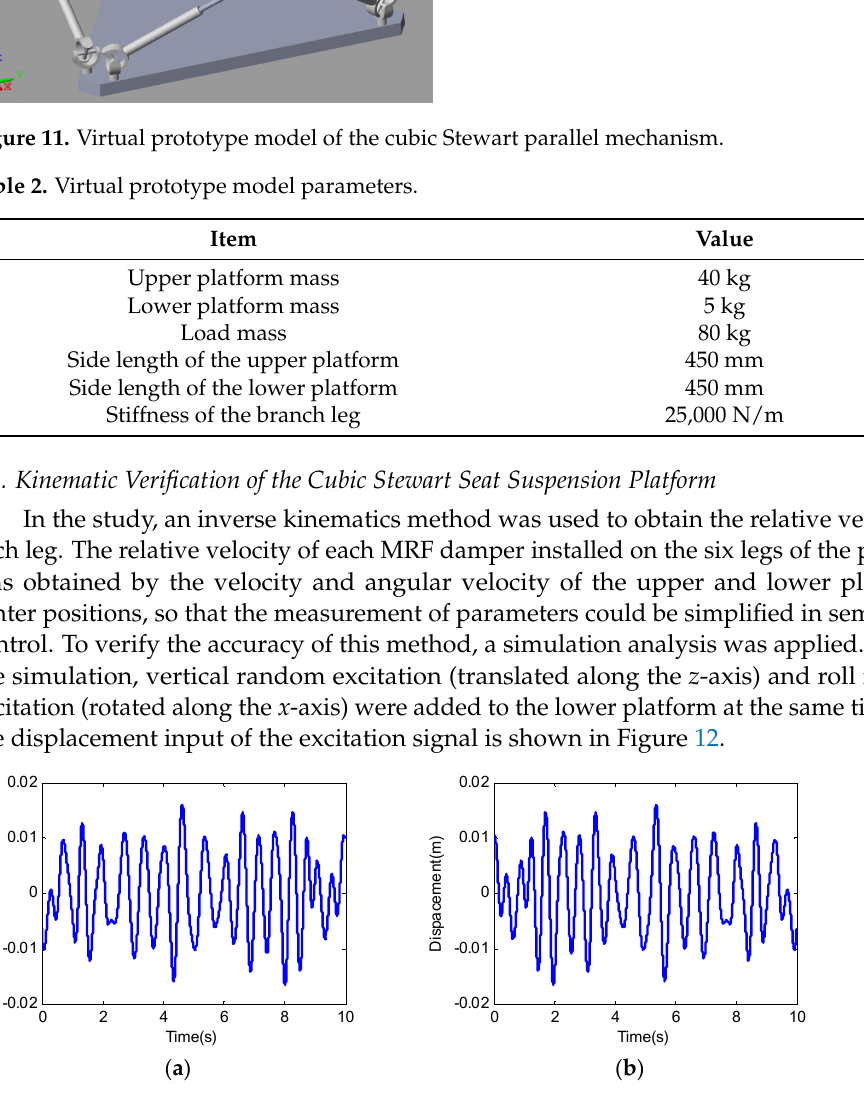
Figure 12. Simulated excitation displacement. ( a ) Roll displacement (rotation along the x -axis); ( b ) vertical displacement (translation along the z -axis).